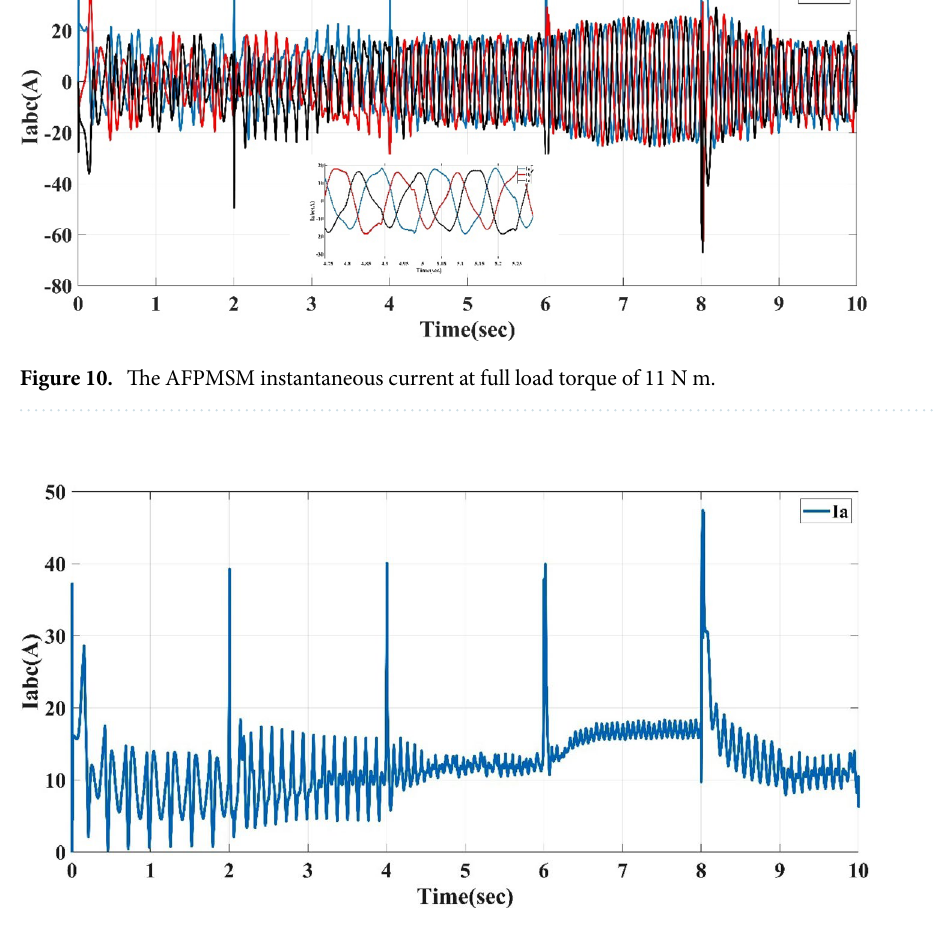
Figure 11. The AFPMSM RMS current at full load torque of 11 N m.